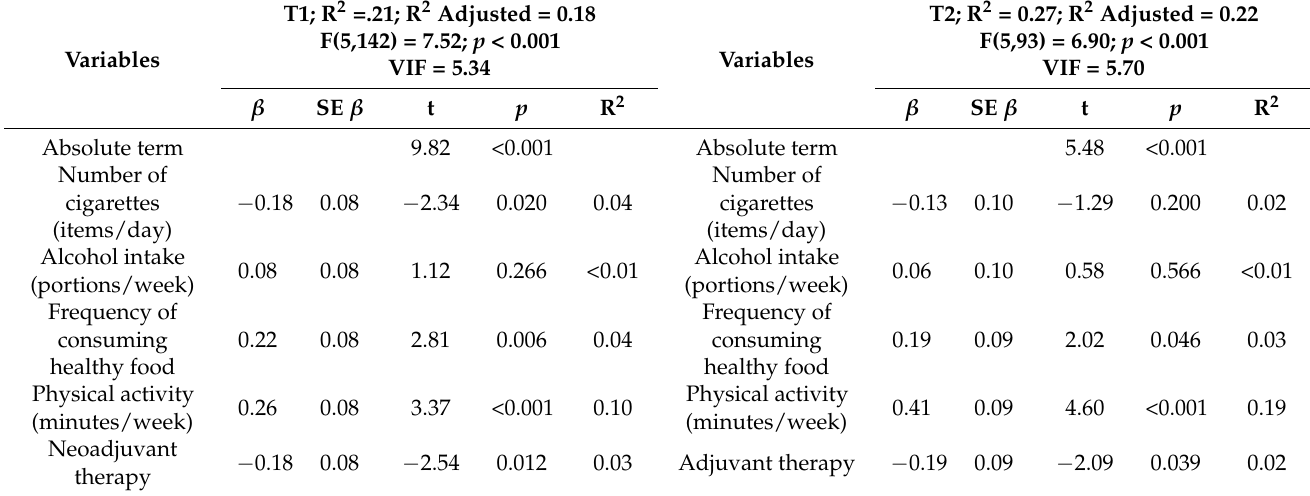
Table 4. The results of the multivariate regression analysis for QoL—physical functioning during T1 and